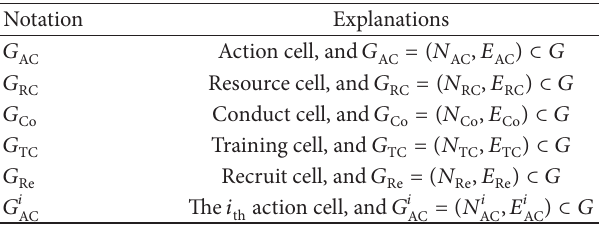
Table 1: The notations of the cells in the cellular network.